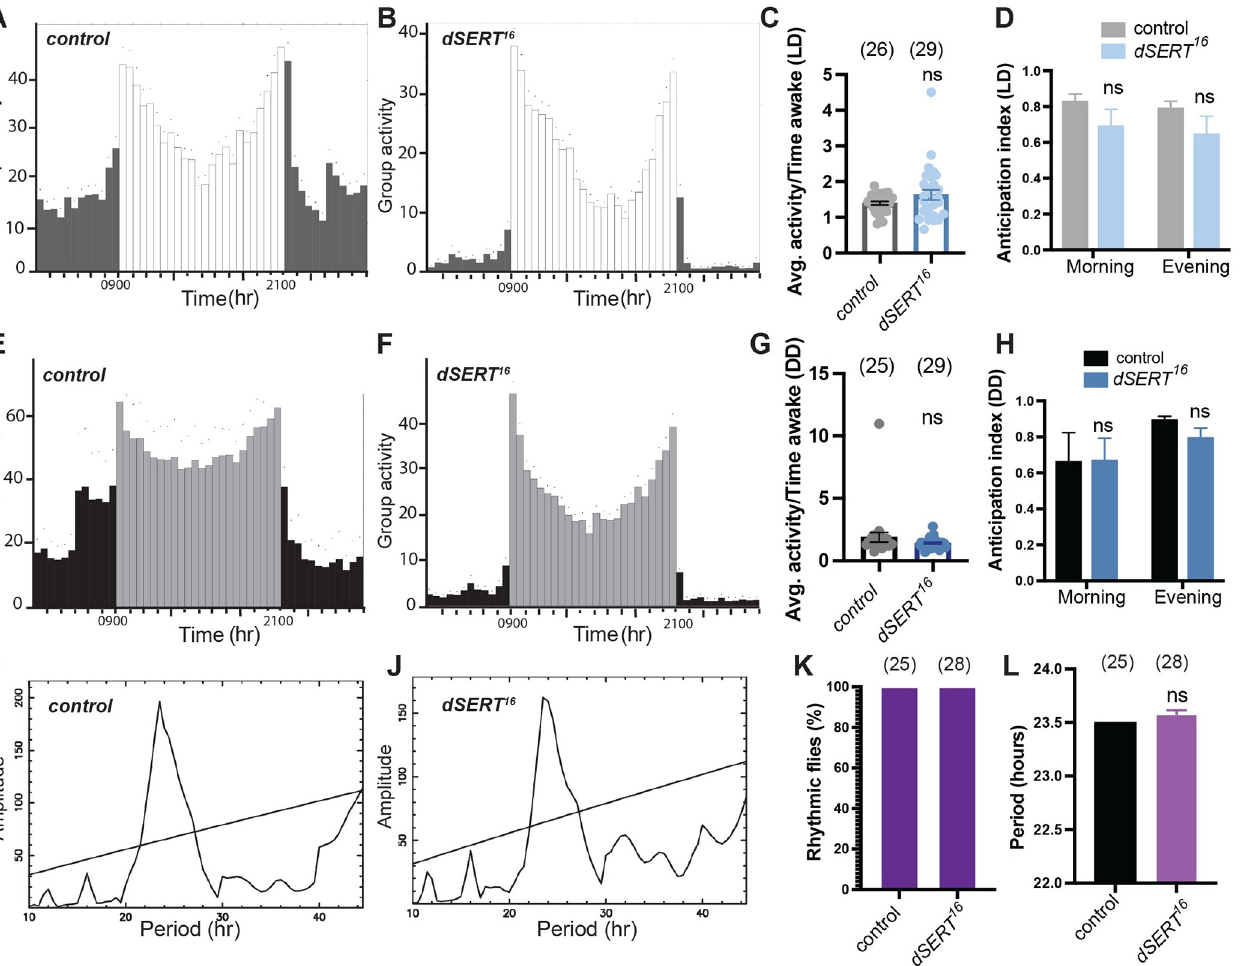
Fig 4. dSERT 16 mutants exhibit rhythmic circadian behaviors. (A-B) 12h:12h LD and (E-F) 12h:12h DD locomotor activity group analysis for w 1118 (A,E) and dSERT 16 (B,F) flies. Histograms represent the distribution of activity through 24 h, averaged over three days, number of flies indicated in C, D, G, H. Lighter and darker bars indicate day and night phases, respectively with 0900 lights-on and 2100 lights-off and each column representing the mean, binned activity for 0.5 hr, n = 25–29 flies. Small dots above each column indicate the SEM. (C,G) The average activity while awake in dSERT 16 mutants is no different than controls in both LD (C) and DD (G) cycles, individual datapoints and group means ± SEM. Student’s t-test, two-tailed unpaired. (D, H) Calculation of morning and evening anticipation indexes for dSERT 16 and control flies in LD (D) and DD (H) cycles. (I-J) Representative periodograms derived from activity records of individual w 1118 (I) and dSERT 16 (J) flies in constant darkness. (K) Percentage of flies with detectable rhythmicity was calculated for controls and dSERT 16 . (L) Circadian periods in DD were averaged from rhythmic flies per each genotype, error bars indicate SEM.